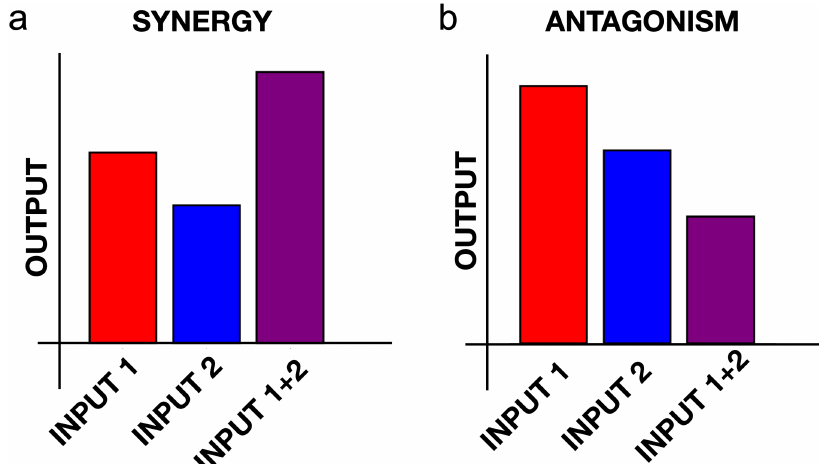
Fig. 2 Synergy vs. antagonism. a A synergistic response to two inputs is larger than the response to either input alone. b An antagonistic response to two inputs is smaller than the response to either input alone. Here we focus on